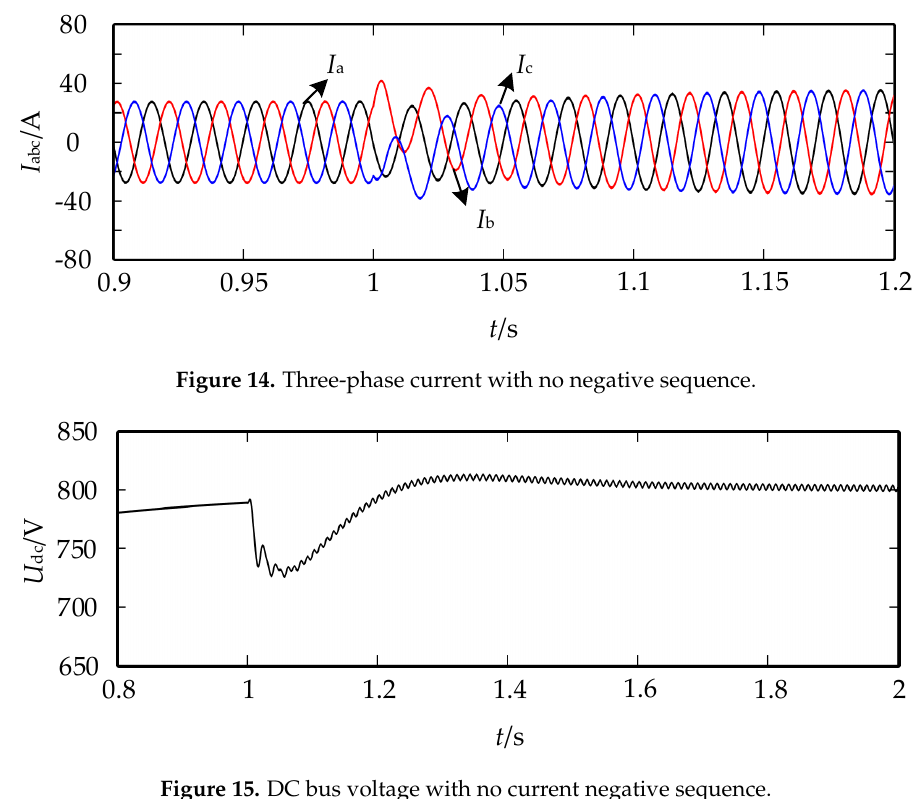
Figure 15. DC bus voltage with no current negative sequence.